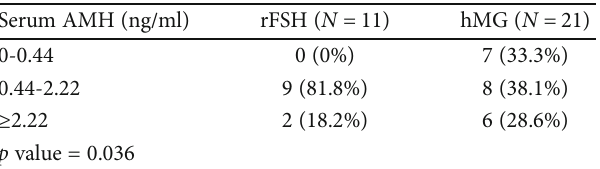
Table 5: Comparative table of di ff erent treatments based on AMH values of the study population. The p value was calculated by the Fisher ’ s exact